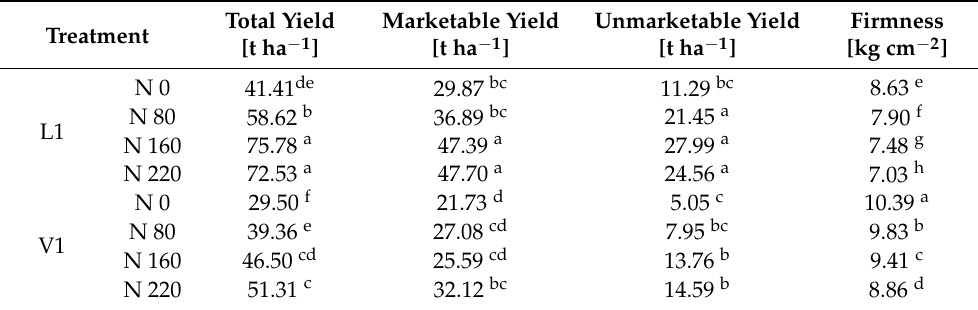
Table 2. Influence of the interaction A × N on the total yield, marketable yield, unmarketable yield, and firmness.